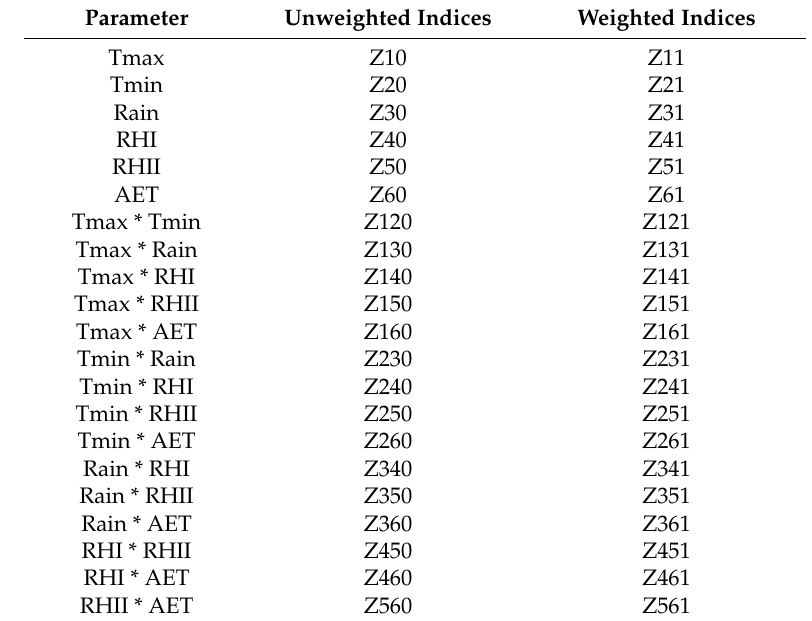
Table 2. Weather indices used for development of multivariate yield forecasting regression models. Parameter Unweighted Indices Weighted Indices Tmax Z10 Z11 Tmin Z20 Z21 Rain Z30 Z31 RHI Z40 Z41 RHII Z50 Z51 AET Z60 Z61 Tmax * Tmin Z120 Z121 Tmax * Rain Z130 Z131 Tmax * RHI Z140 Z141 Tmax * RHII Z150 Z151 Tmax * AET Z160 Z161 Tmin * Rain Z230 Z231 Tmin * RHI Z240 Z241 Tmin * RHII Z250 Z251 Tmin * AET Z260 Z261 Rain * RHI Z340 Z341 Rain * RHII Z350 Z351 Rain * AET Z360 Z361 RHI * RHII Z450 Z451 RHI * AET Z460 Z461 RHII * AET Z560